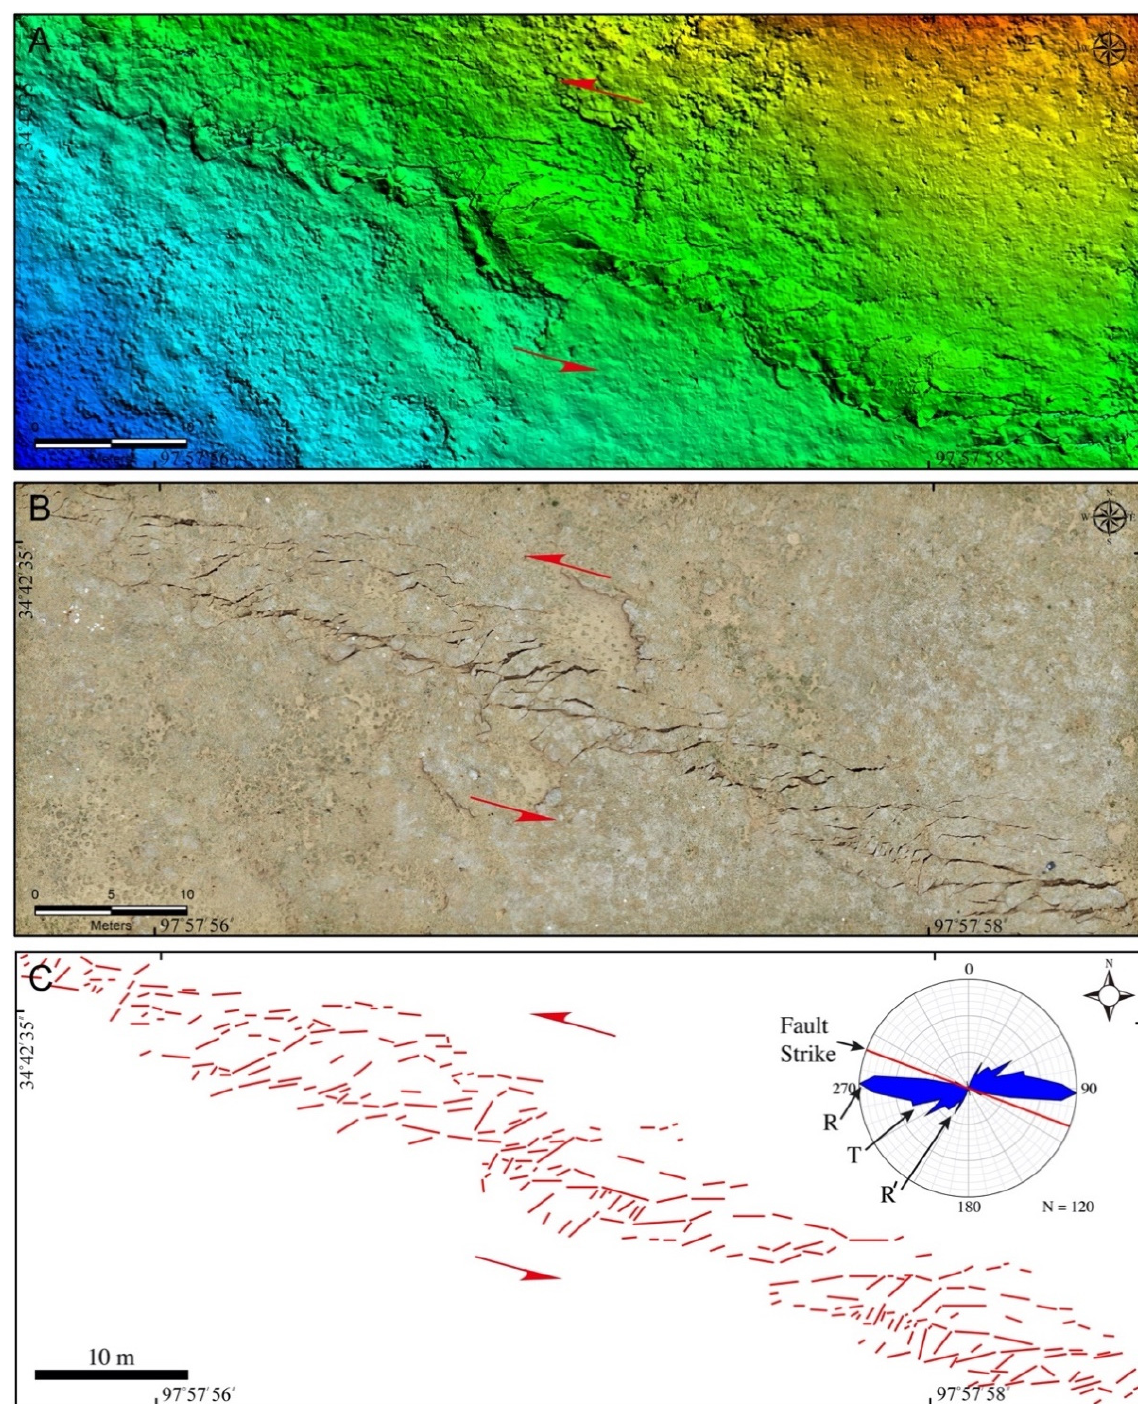
Figure 4. Drone data processing results and fracture distribution statistics. ( A ) DEM of the surface rupture. ( B ) Orthophoto of the area shown in panel ( A ). ( C ) Fracture distribution and rose diagram, R shears, R ′ shears, and T fractures are major fractures.